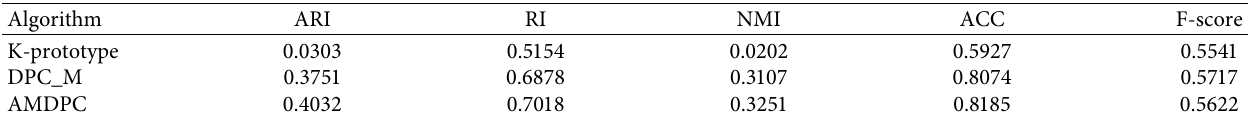
Table 4: Clustering results of Heart dataset.